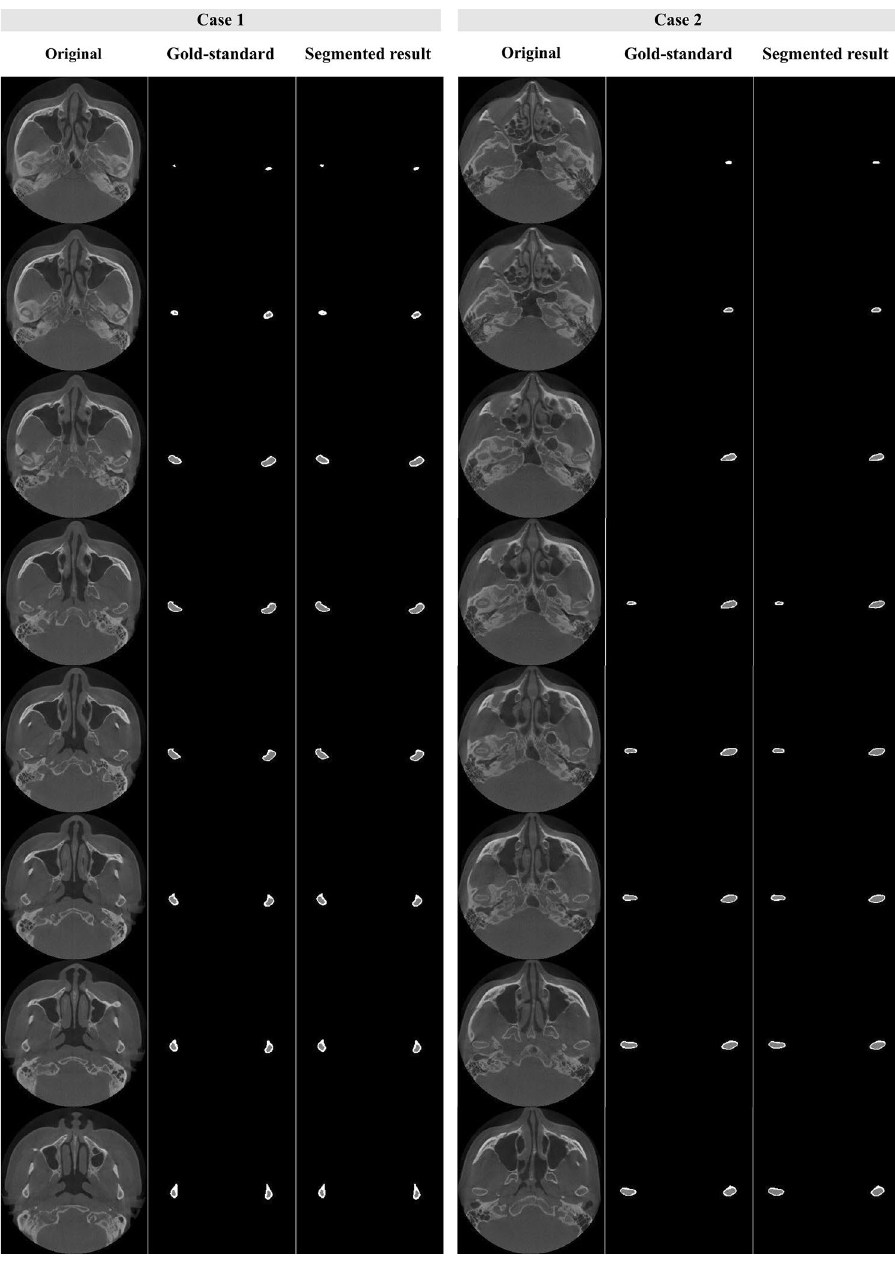
Figure 4. Examples of visual evaluation of the deep learning-based segmented model. The gold-standard is the manual labels annotated by an expert and the segmented result is the labels predicted by the proposed convolutional neural network